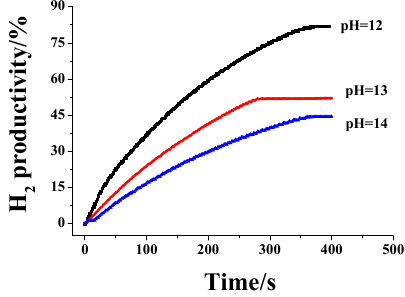
Figure 6. Evaluation of H 2 productivity with reaction time of Rh 10 Ni 90 BNPs at different pH values ( R ISO = 40, C Metal = 0.66 mM, reduced under ice ‐ water bath for 1 h; 30 °C).